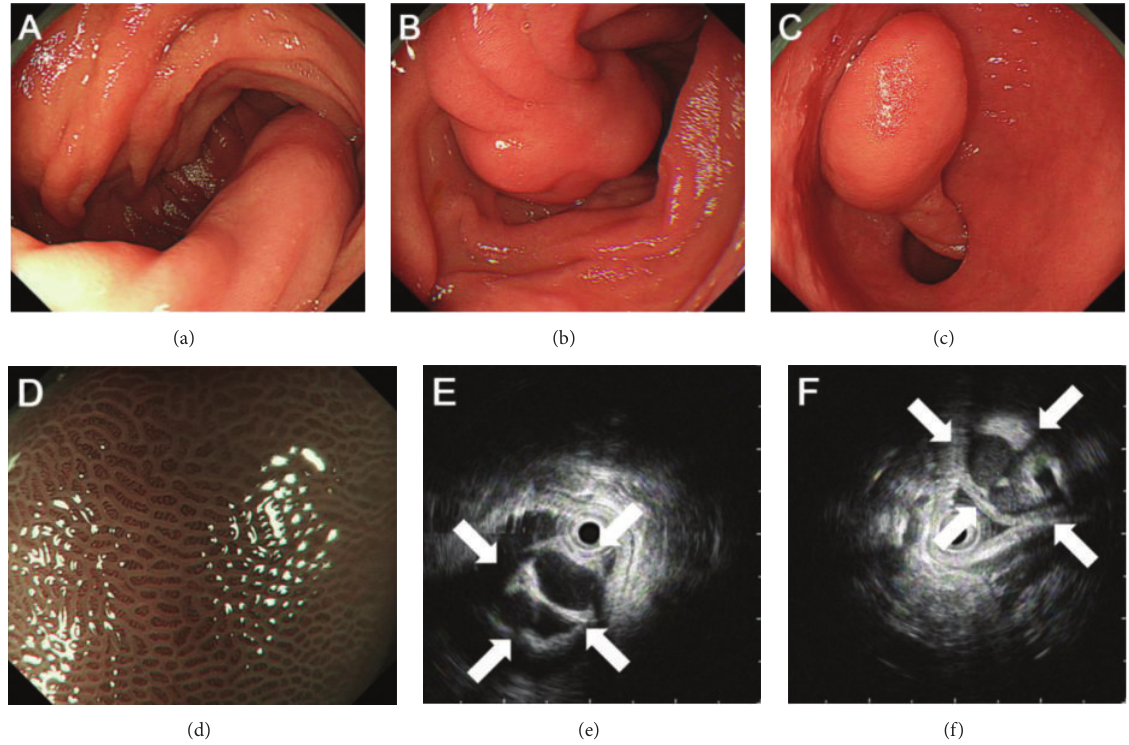
Figure 2: Endoscopy images. Esophagogastroduodenoscopy results showed a pedunculated polyp measuring approximately 20 mm ((a), (b)). The polyp was easily extended to the stomach by traction with biopsy forceps (c). Magnifying observation with narrowband imaging revealed that the surface of the polyp was entirely covered with intact duodenal mucosa (d). Endoscopic ultrasonography showed multiple cystic structures ((e), (f),